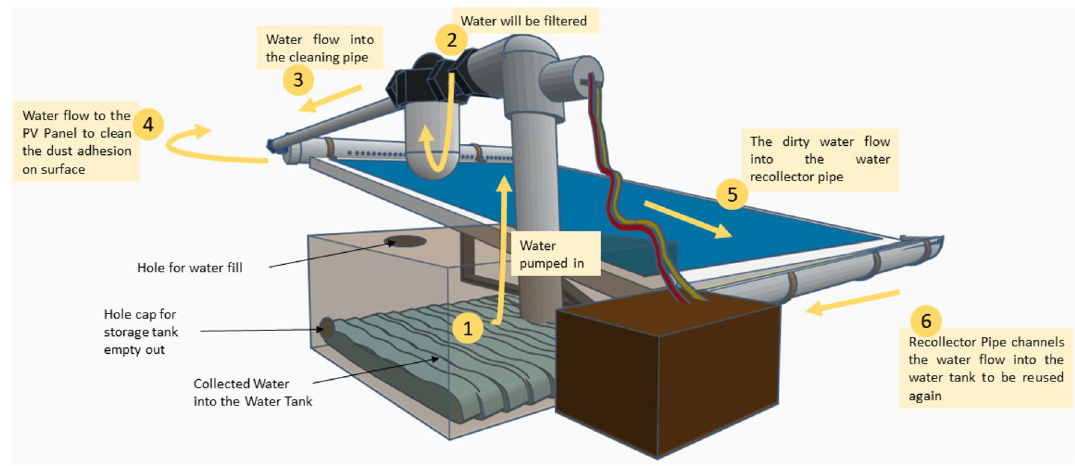
Fig. 3 Conceptual 3D design of novel prototype—automated adhesion dust-fall cleaning or AWR method (used tinkercad.com application